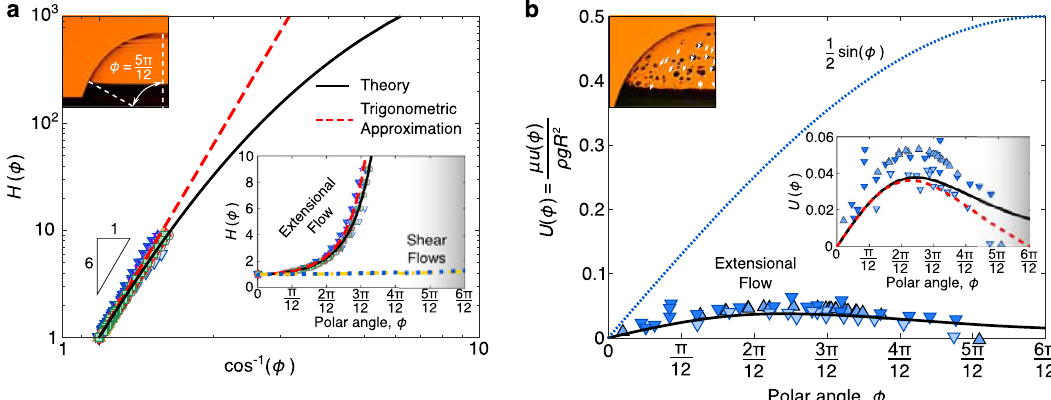
Fig.4|Comparisonofexperimentsandtheoryforthespatialcomponentofthe universal drainage. a Logarithmic plot of the spatial function H ( ϕ ) against the secant of the polar angle ϕ . The numerical solution (solid line) nicely matches the experimentaldata.Thespatialfunctioncanalsobeestimatedusingatrigonometric approximation (dashed line), which follows the scaling H ð ϕ Þ ∼ cos (cid:2) 6 ϕ . Inset: In contrasttoanextensional fl owwithtwostress-freeinterfaces(blacksolidline)that cause a spatial divergence of the thickness, shear fl ows with one 15 (yellow dashed